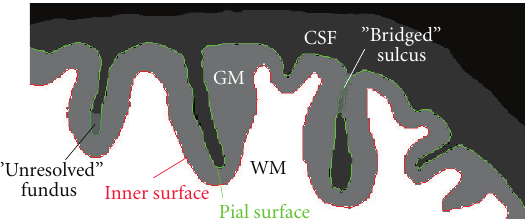
Figure 1: Schematic illustration of a fragment of brain slice. Contours of the inner and pial surface are marked in red and green. Due to partial volume e ff ects and limited resolution, adjacent banks of gray matter in some sulci may appear as fused together, creating either a “bridged” sulcus or an unresolved sulcal fundus (a “buried” sulcus). Note that a “bridged” sulcus creates a topological defect, a handle, which may be corrected by a topology-preserving model, whereas a “buried” sulcus does not change the